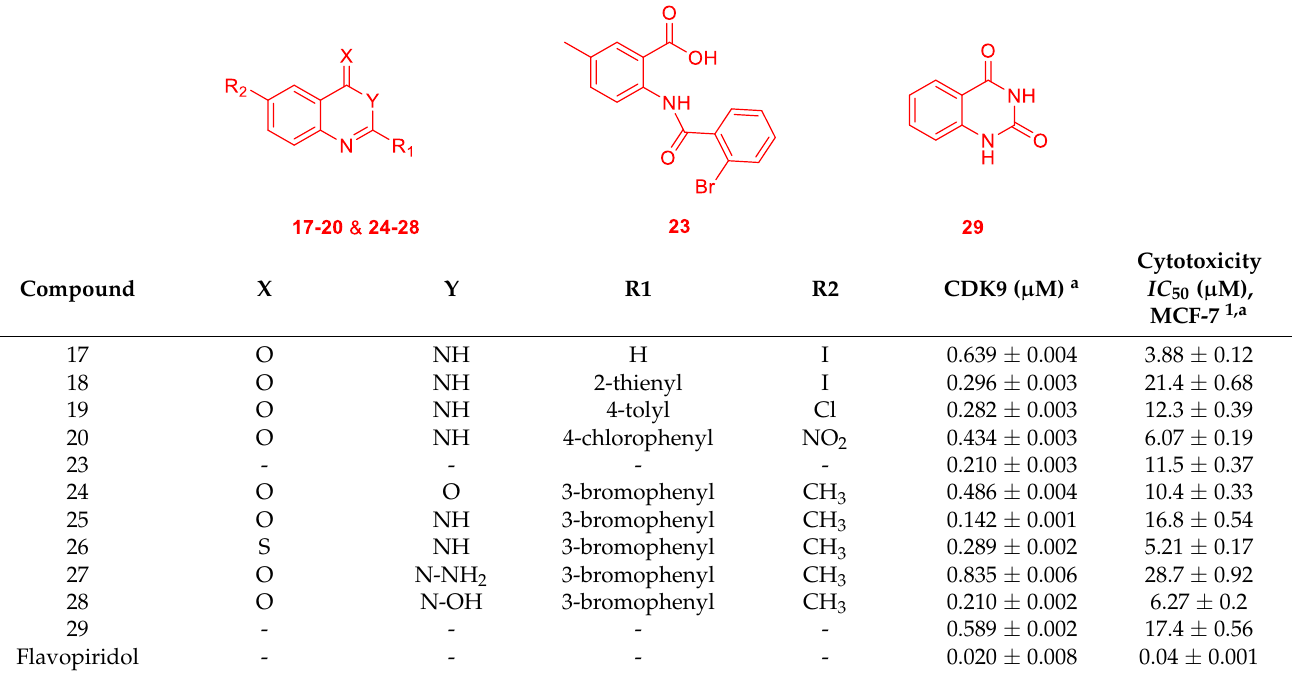
Table 2. Structures of compounds 17 – 20 and 23 - 29 and their biological activity. Table 2 . Structures of compounds 17 – 20 and 23 - 29 and their biological